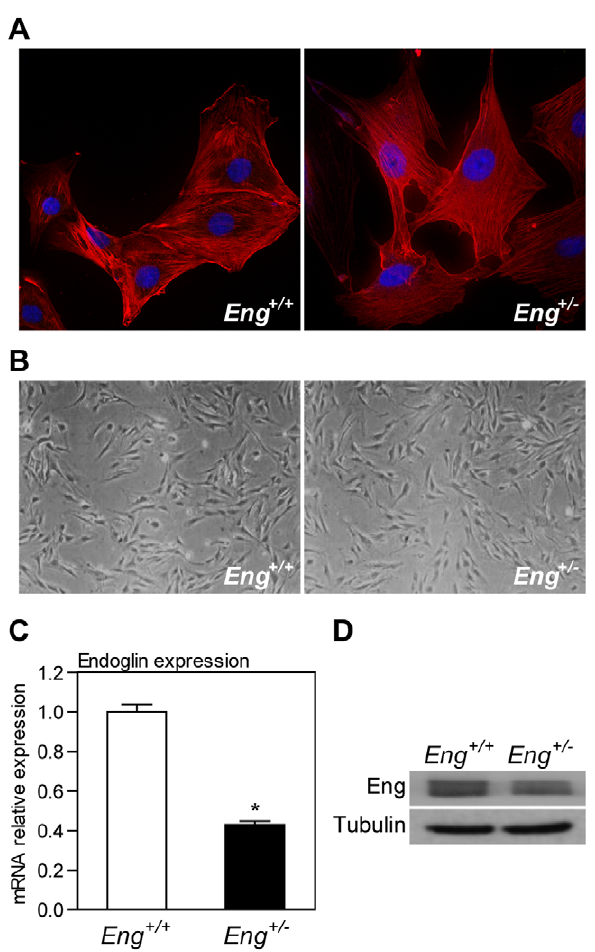
Figure 2. Characterization of primary cultured murine dermal fibroblasts (MDF) from endoglin heterozygous mice. ( A ) Immunofluorescence analysis of a -SMA expression in Eng + / + and Eng + / 2 MDF. ( B ) Phase contrast analysis of Eng + / + and Eng + / 2 MDF morphology. ( C and D ) Analysis of relative endoglin expression between Eng + / + and Eng + / 2 MDF by quantitative RT-PCR ( C ) and western blot ( D ). Mean + SEM is represented (n=3). * p , 0.05 - significance of the difference between cells, Student’s t -test. A representative blot from three independent experiments is shown.